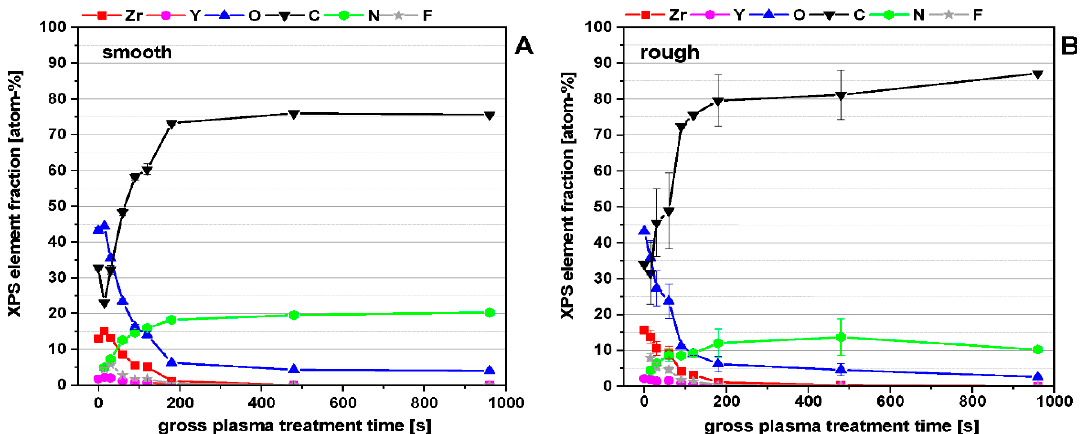
Figure 8. X-ray photoelectron spectroscopy (XPS) elemental content of PPAAm coating on a smooth ( A ) and rough ( B ) ceramic surface dependent on the treatment time. For a clearer presentation, the trace elements Al, Si, and Na were omitted.